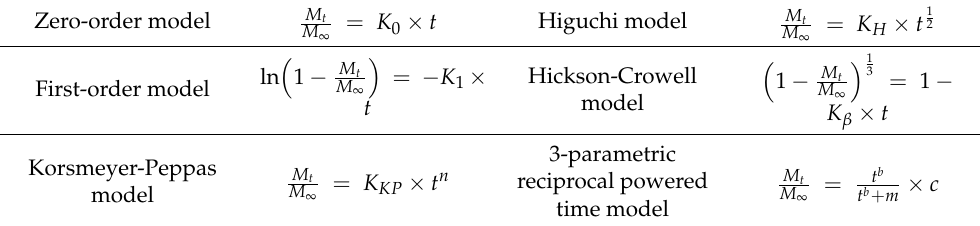
Table 6. Summary of the different release models applied to analyze the in vitro release data. In this summary, M t represents the amount of the drug released over a certain time ( t ) and M ∞ represents the total drug amount. The parameter n denotes the diffusion coefficient in the Korsmeyer-Peppas equation. In the 3RPT model, M t / M ∞ represents the fraction of the dose released, m —the time at which 50% of the plateau phase has been reached, parameter b determines the shape of the profile, c —the released fraction in the plateau